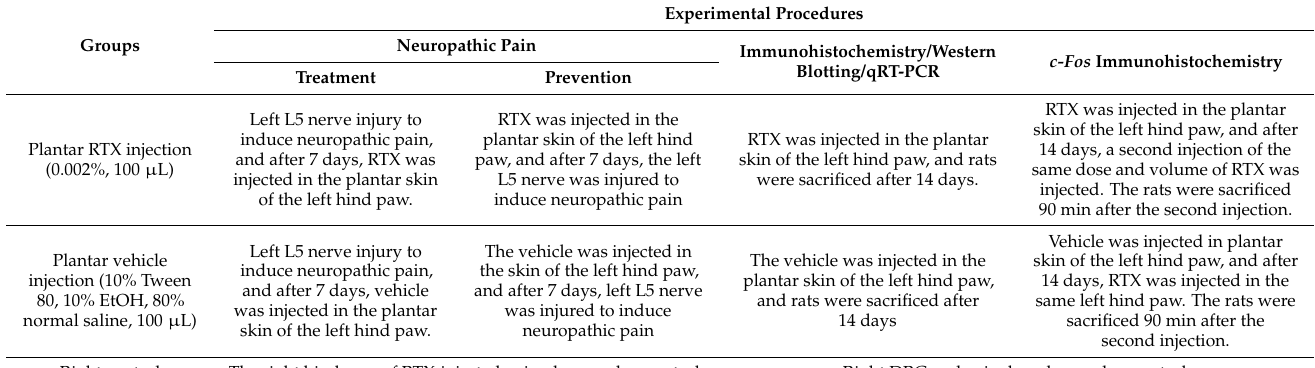
Table 1. Experimental